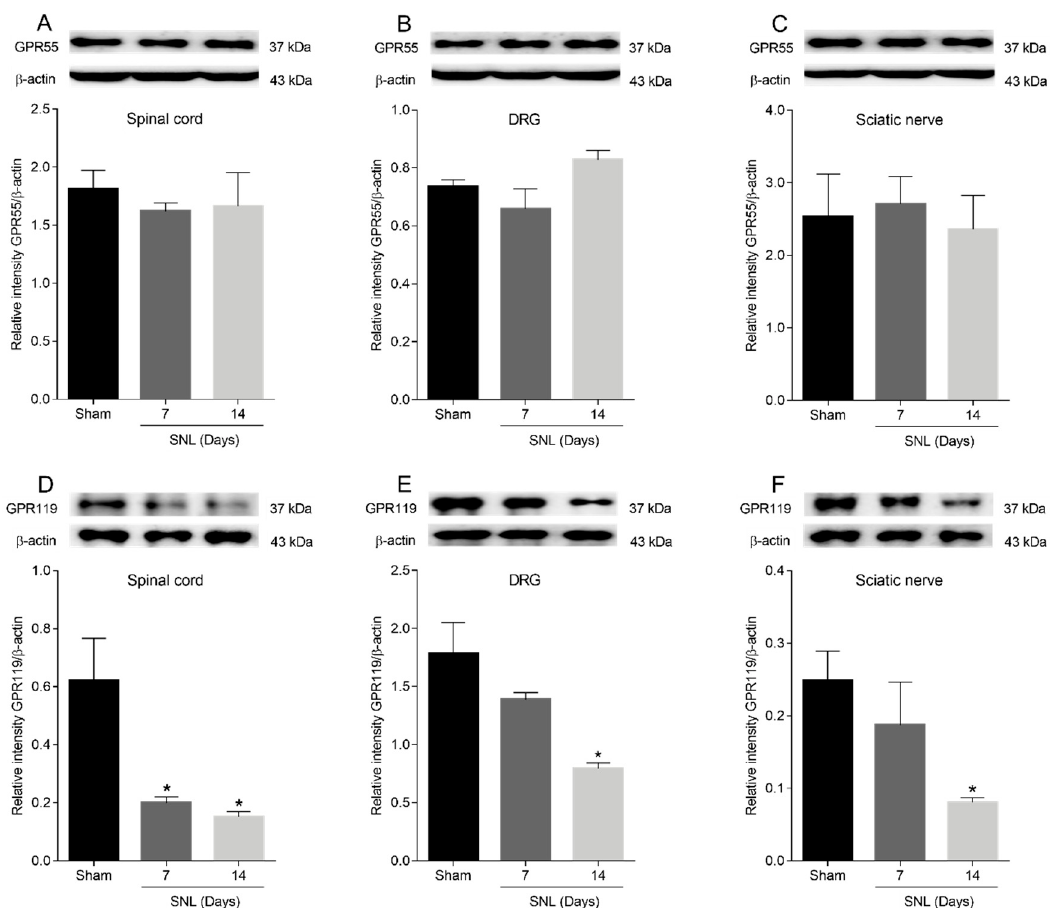
Figure 5. Western blotting analysis of GPR55 ( A – C ) and GPR119 ( D – F ) protein expression in ipsi- lateral lumbar spinal cord, L5-L6 dorsal root ganglia (DRG) and sciatic nerve of sham and L5-L6 spinal nerve ligation-induced neuropathic rats. Data were standardized in contrast to β -actin and they represent the mean ± SEM of three independent experiments per group, where each experiment incorporated the tissue mixture of three rats. * Significantly different from sham group by one-way analysis of variance, followed by post hoc Dunnett’s test with a p < 0.05. Abbreviations: SNL = spinal nerve ligation.